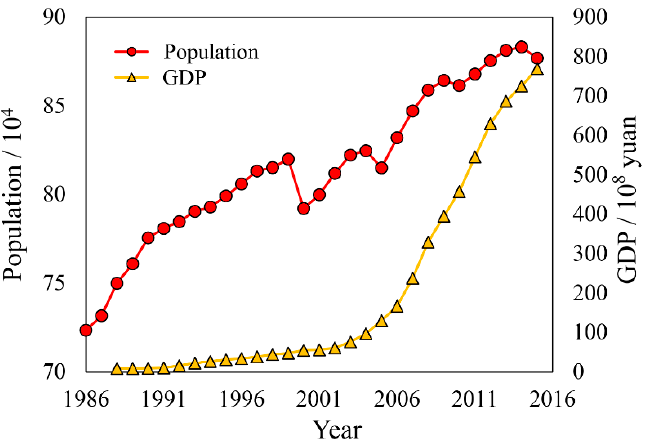
Figure A4. Spatial distribution of correlation between annual precipitation, annual mean tempera ‐ ture and desertification index in OSL. ( a ) Correlation of precipitation; ( b ) Correlation significance of precipitation; ( c ) Correlation of temperature ( d ) Correlation significance of temperature.